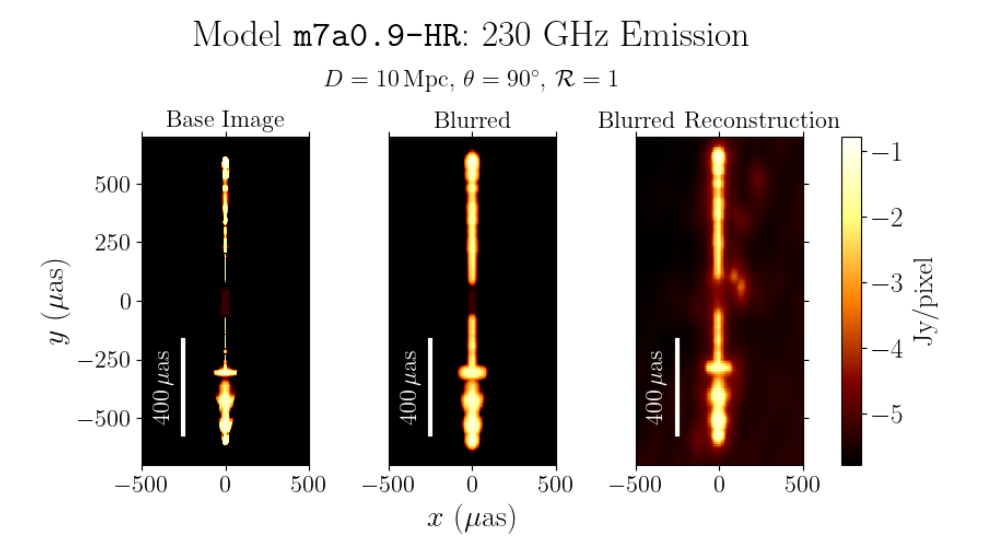
Figure 2. Model m7a0.9-HR at t = 78,000 t g imaged at D = 10 Mpc with θ = 90 ◦ and R = 1. We show the base ipole image with no blurring ( left ), the base ipole image blurred via convolution with a 20 µ as FWHM Gaussian beam ( middle ), and the reconstructed image blurred using the same Gaussian beam ( right